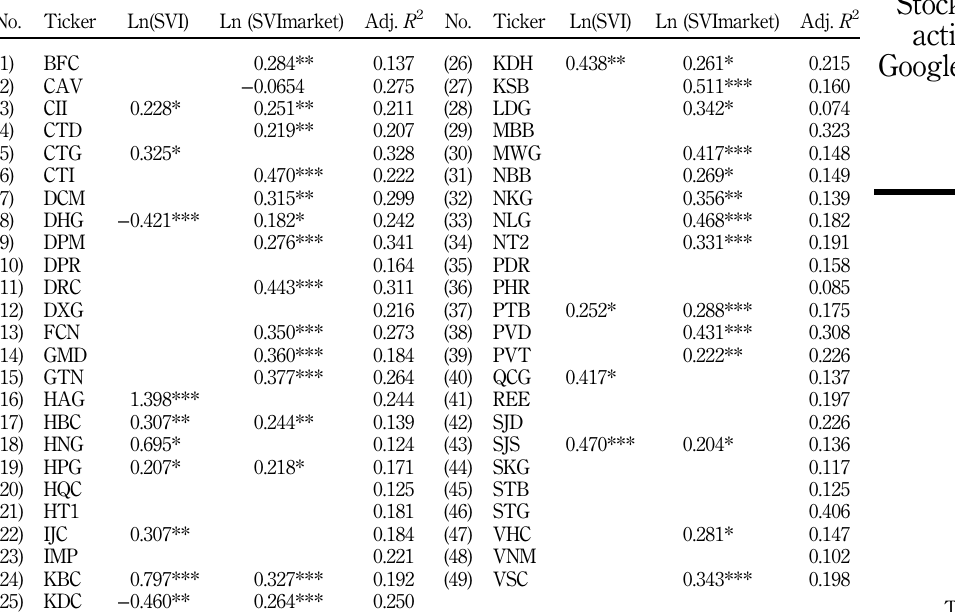
Table VI. The impact of investor attention on stock